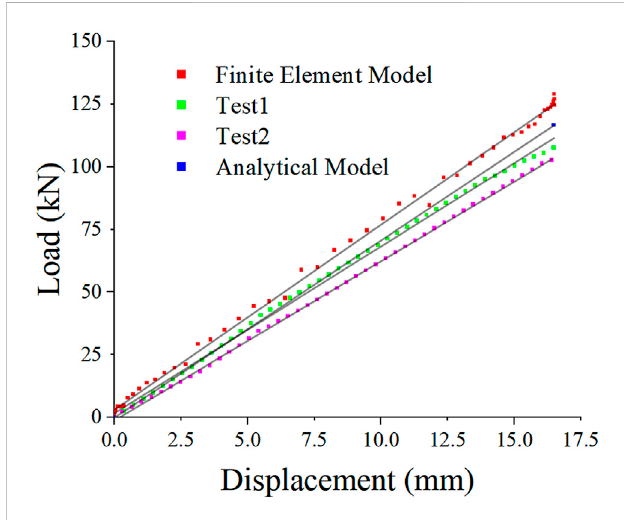
FIGURE 8 Load-displacement curves obtained by different methods.